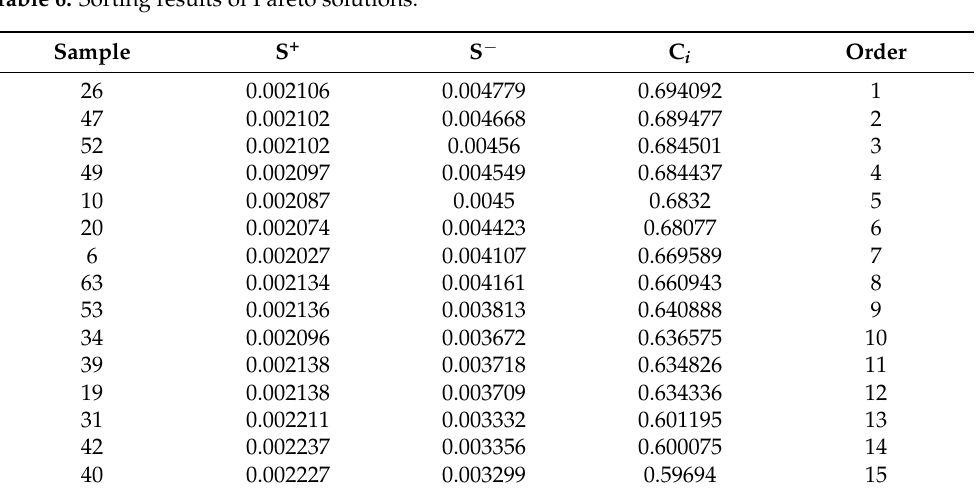
Table 6. Sorting results of Pareto solutions.